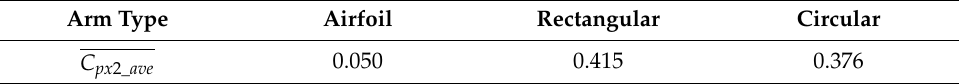
Table 3. Pressure-based tangential force coe ffi cients averaged along the arm span direction.